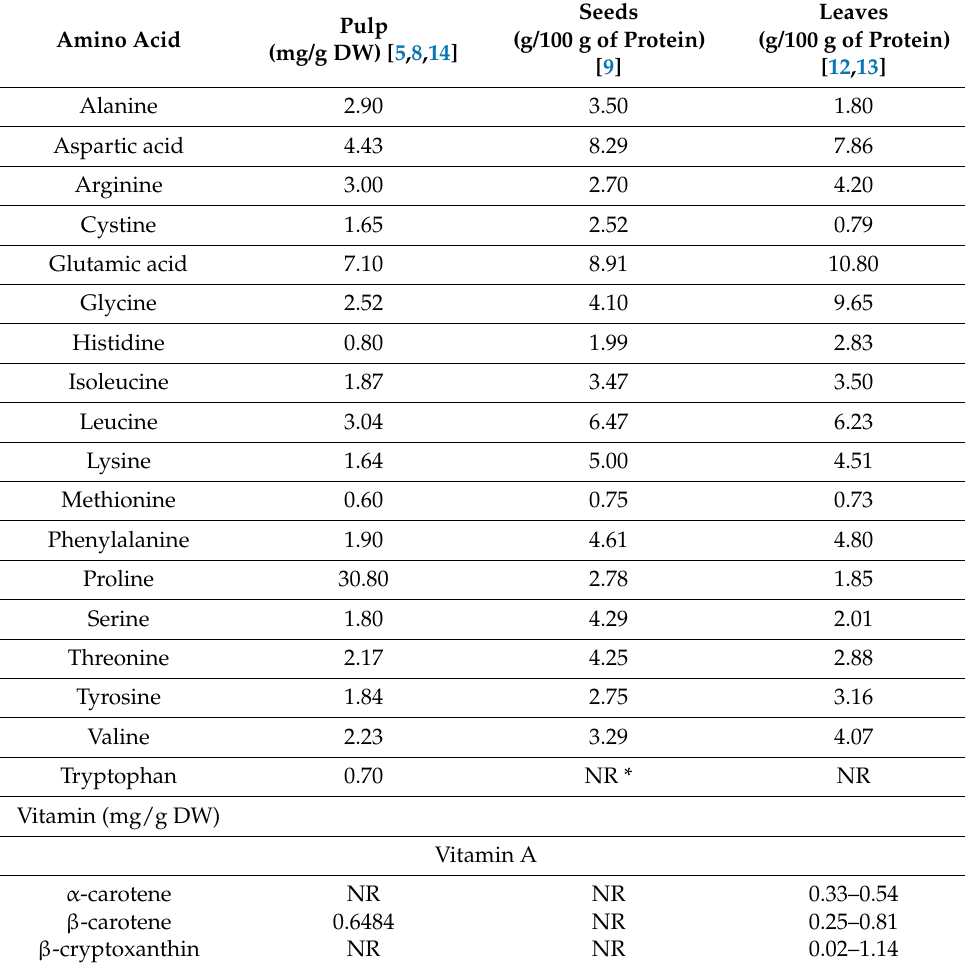
Table 3. Amino acid and vitamin composition of desert date pulp, seeds and